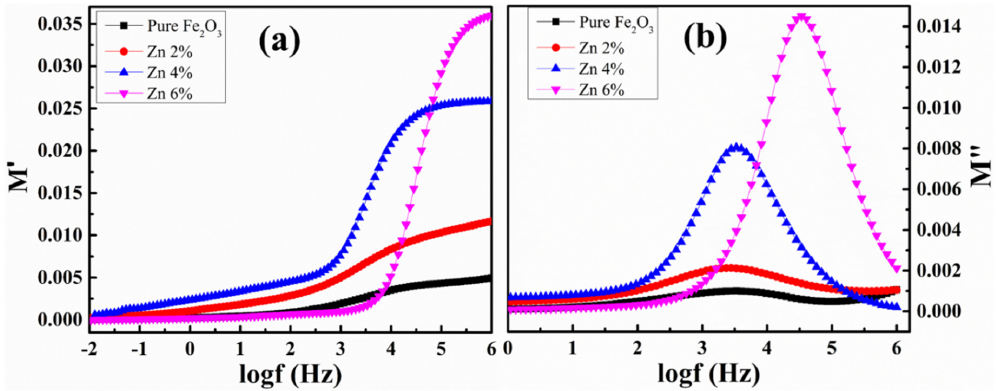
Figure 13. Frequency dependence ( a ) real component (M’) and ( b ) Imaginary component (M”) of